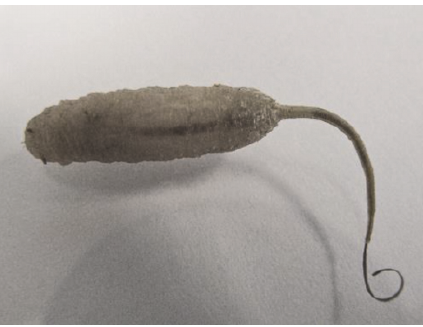
Figure 1: Larva of the rat-tailed maggot, Eristalis tenax, about 2.6 ± 0.7 cm in